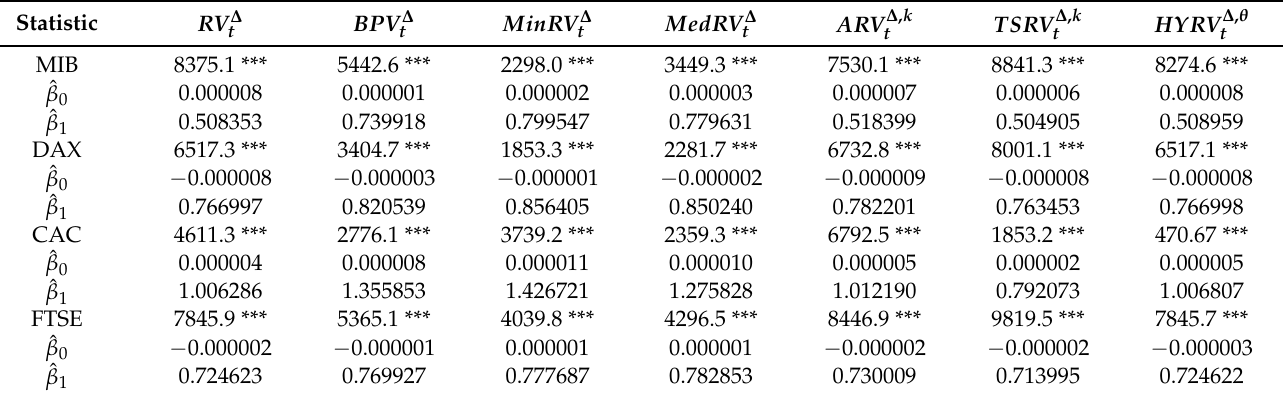
Table 4. Results of Mincer–Zarnowitz regression.